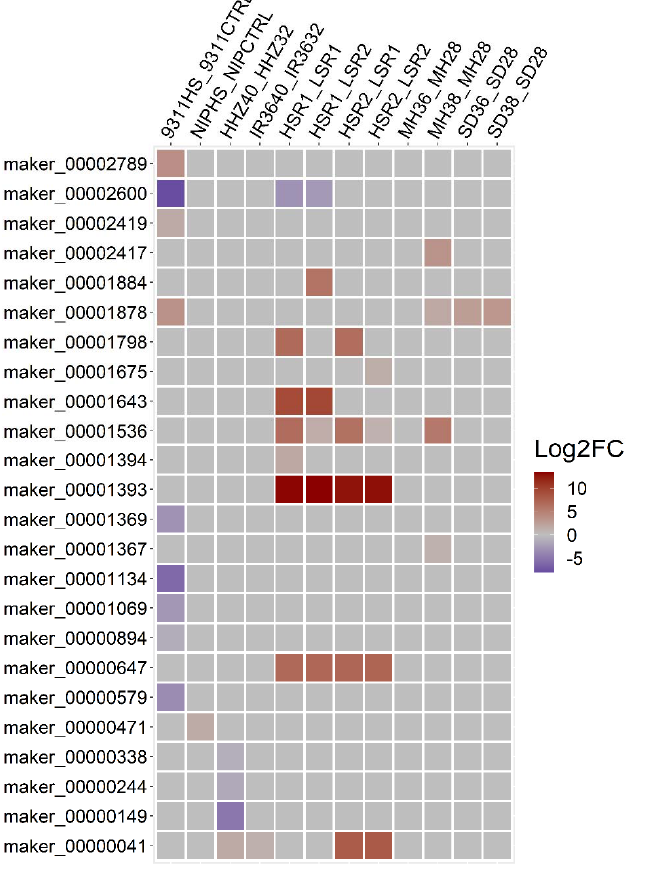
Figure 6. Differential expression profile of the genes with heat stress tolerance-related SNPs in different transcriptomic datasets of rice under heat stress. Based on the functional and GO-based annotation, we found that some of the 24 non- reference genes with heat stress tolerance-related SNPs were homologous to the genes in wild rice. Calmodulin-binding protein 60 A-like (maker_00000041) was upregulated in two RNA-seq datasets of rice under heat stress, with 99.8% similarity to the ORUFI11G23900.1 gene in Oryza rufipogon . The cysteine-rich receptor-like protein kinase 6 ( maker_00001878 ) gene upregulated in two RNA-seq datasets was homologous to the OBART07G17510.1 gene in Oryza barthii , with an identity of 81.4%. The thiol methyltransferase 2 domain- containing protein ( maker_00001393) gene was homologous to the OGLUM03G40460.1 gene in Oryza glumipatula . The sulfotransferase (maker_00000647) gene was identified to